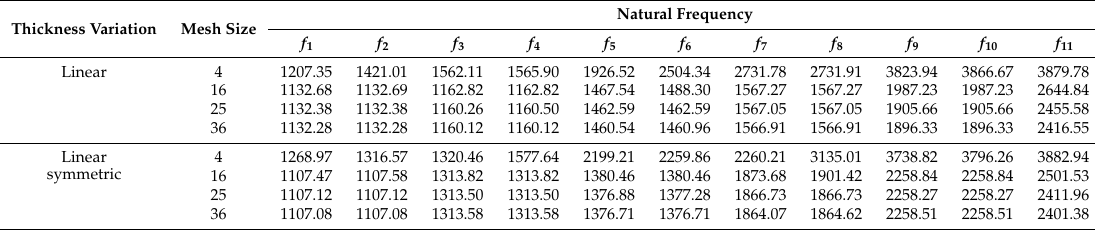
Table 5. Convergence of natural frequencies for a cylinder of ratio r / h m = 100 and CF boundary